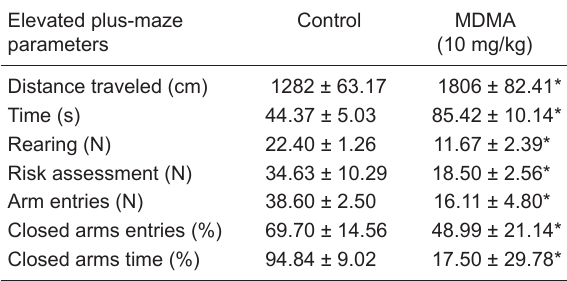
Table 2. Effects of 3,4-methylenedioxymethamphetamine (MDMA, 10 mg/kg) on BALB/c male mice in the elevated plus maze 60 min after treatment.